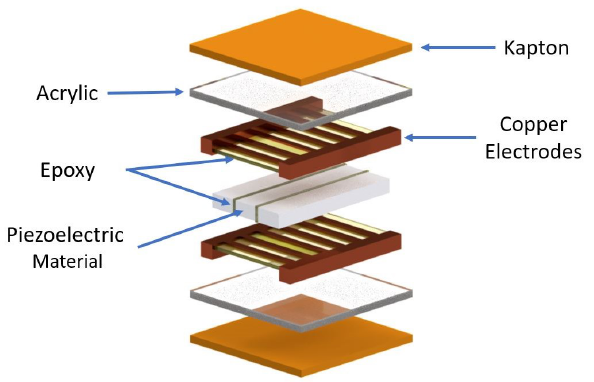
Figure 2. Representation of the Separated Layers Normally Present in the Macro Fiber Composites